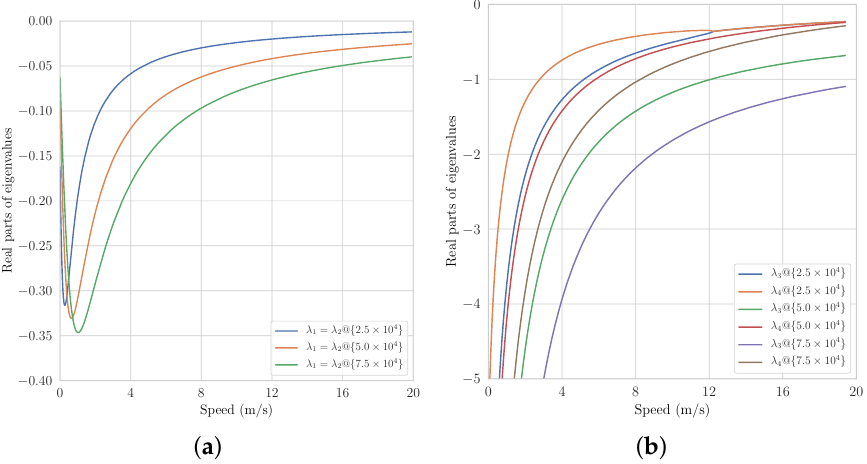
Figure 10. Variation of the real parts of the eigenvalues with the tire stiffness: ( a ) real parts of λ 1 and λ 2 and ( b ) real parts of λ 3 and λ 4